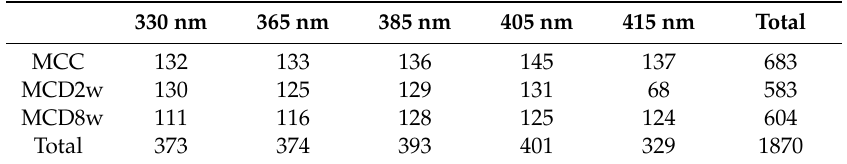
Table 5. Distribution of the number of measured fluorescence spectra per group and excitation